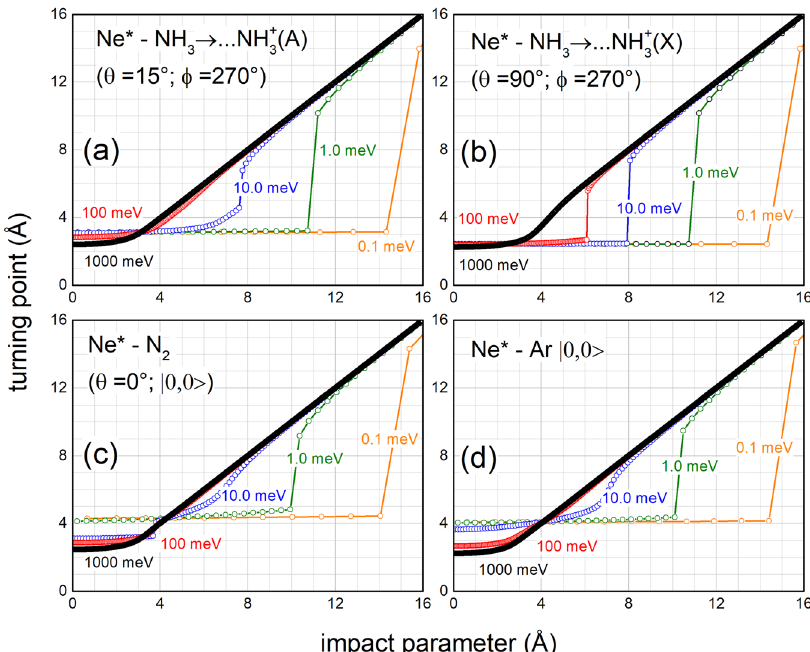
+ (A) electronic excited ions ( a ), Ne * + NH + (X) 3 producing NH 3 3 producing NH 3